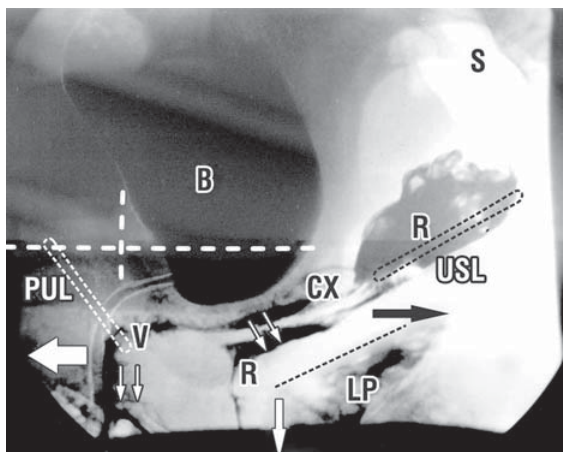
Figure 1 – A sitting X-ray taken in the straining position, with radio-opaque dye injected into the bladder (B), vagina (V), rec- tum (R), levator plate (LP). PUL and USL represent the pu- bourethral and uterosacral suspensory ligaments. The organs are tensioned like a trampoline by the muscle forces (arrows) contracting against the suspensory